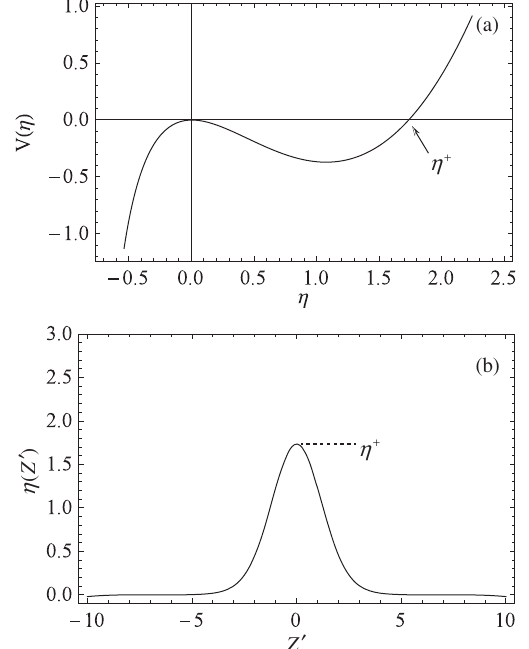
FIG. 9. Plots of (a) V ð η Þ versus η ; and (b) η ð Z 0 Þ versus Z 0 , obtained from Eqs. (56) and (62) for M 2 ¼ 1 . 2 , ϵ 4 = 15 and E ¼ 0 , corresponding to soliton amplitudes η þ ¼ 0 . 4 T ¼